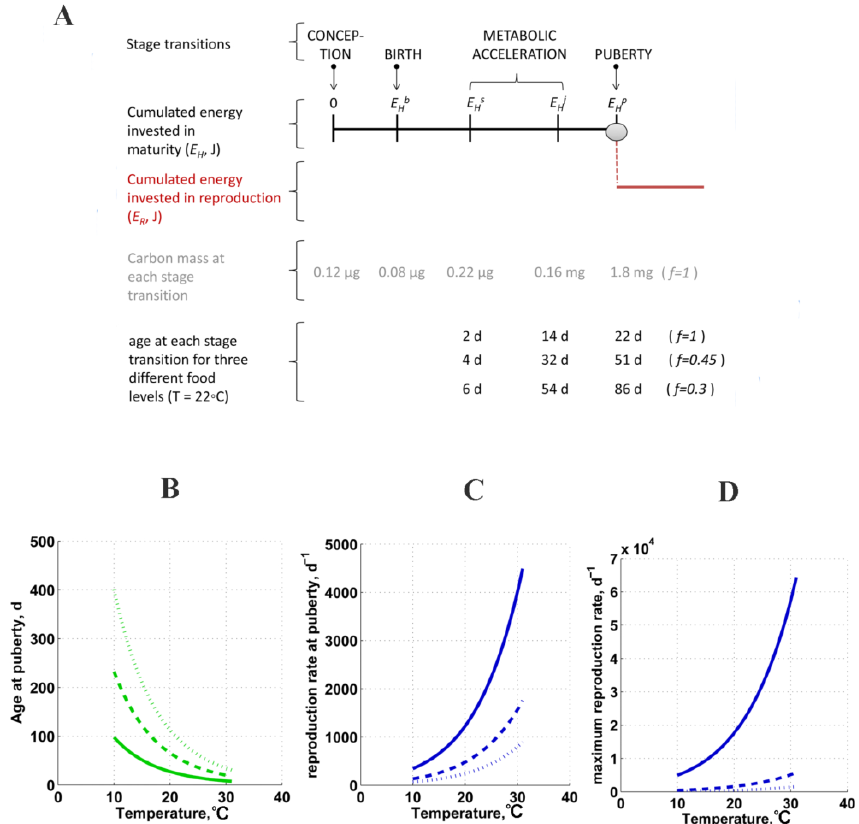
Figure 9. Results of DEB model simulations – (a) grey: carbon mass at stage transitions at f = 1 . Below are presented the ages at each stage transition for three different ingestion levels ranging from 1 to 0.3. (b) Age at puberty as function of temperature. (c–b) Reproduction rate at puberty and at ultimate mass and respectively as function of temperature. (a–c) Simulations are for three ingestion levels: f = 1 (solid line), f = 0 . 45 (dashed line) and f = 0 . 3 (dotted